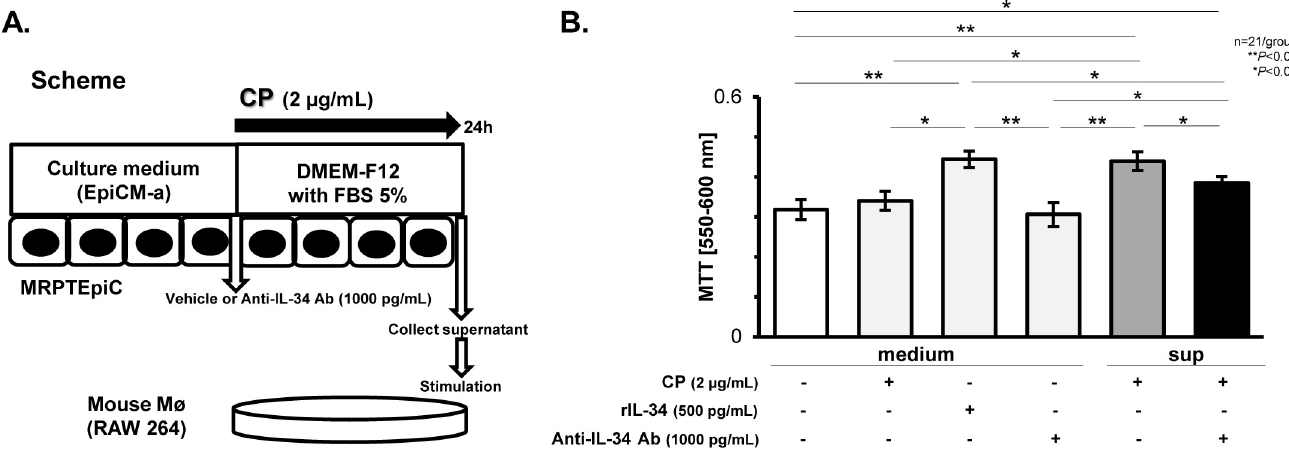
Fig 2. M ø proliferation induced by the culture supernatants of MRPTEpiC stimulated with CP. Scheme for the analysis. Mouse M ø s (RAW 264) were cultured with medium or the culture supernatant of MRPTEpiC stimulated with CP (2 μ g/mL) for 24 h. The medium for culturing RAW 264 contained vehicle, CP, rIL-34 (500 pg/mL), or anti-IL-34 Ab (1000 pg/mL). CP-stimulated MRPTEpiC were treated with vehicle or anti-IL-34 Ab (1000 pg/mL), followed by the collection of the supernatant to culture RAW 264 ( A ). MTT assay for M ø proliferation among the study groups ( B ). Data are expressed as the mean ± SEM. The Mann-Whitney U test was used for statistical